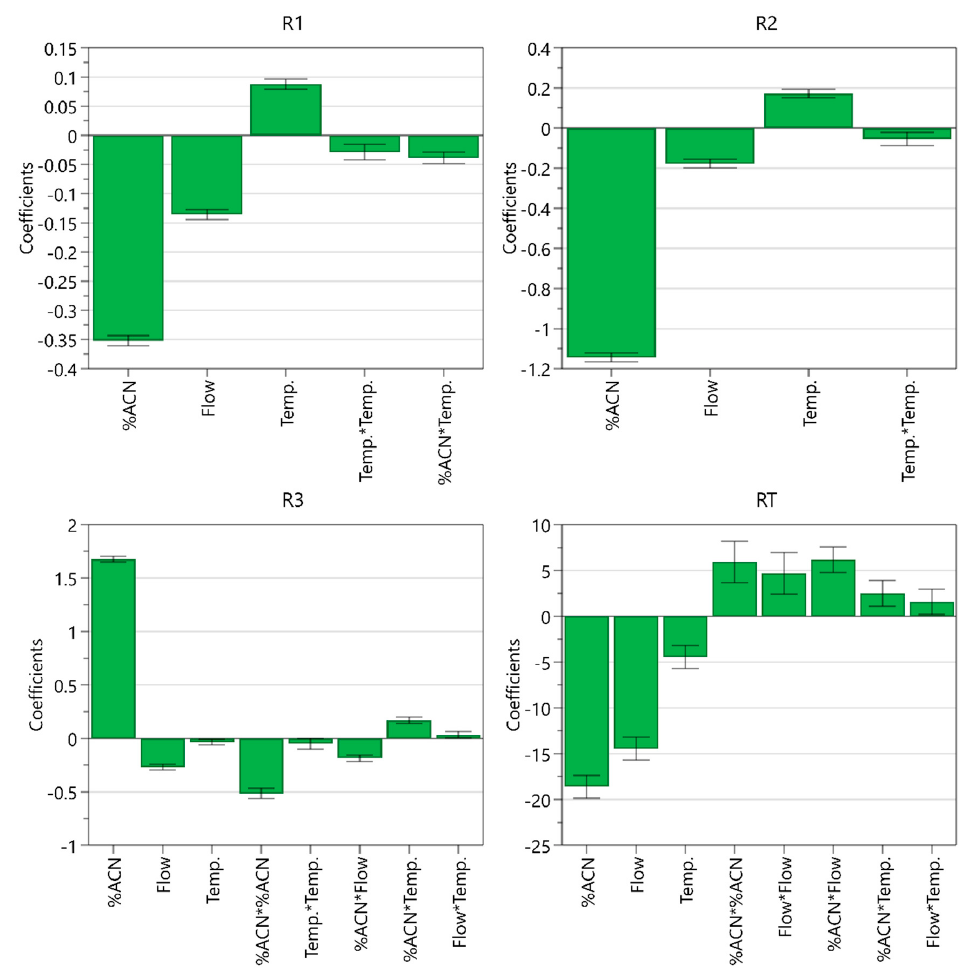
Figure 6. Coe ffi cient plot for models created displaying their coe ffi cients and confidence Figure 6. Coefficient plot for models created displaying their coefficients and confidence intervals. The dependence of each CMA measured on the CMPs investigated can also be presented in graphic form as a contour plot. When contour plots are overlapped, a sweet spot plot is obtained, representing the areas where all CMA criteria are met and where one or more CMA requirements are not met. For the models obtained, a sweet spot plot was created using the MODDE integrated sweet spot analysis tool. The sweet spot plot is presented in Figure 7. The green area represents a sweet spot, a part where all CMA criteria are met, and the light green area is where one criterion is not met. From the plot presented, it can be seen that a higher column temperature offers a larger area where the changes in CMPs do not cause variation in CMAs outside their acceptable values. For example, using a column temperature of 40 °C, the ratio of acetonitrile in the mobile phase can vary between 43.5% and 46.5% if the flow rate is maintained between 0.7 mL/min and 0.9 mL/min to still fulfill the CMA requirements.